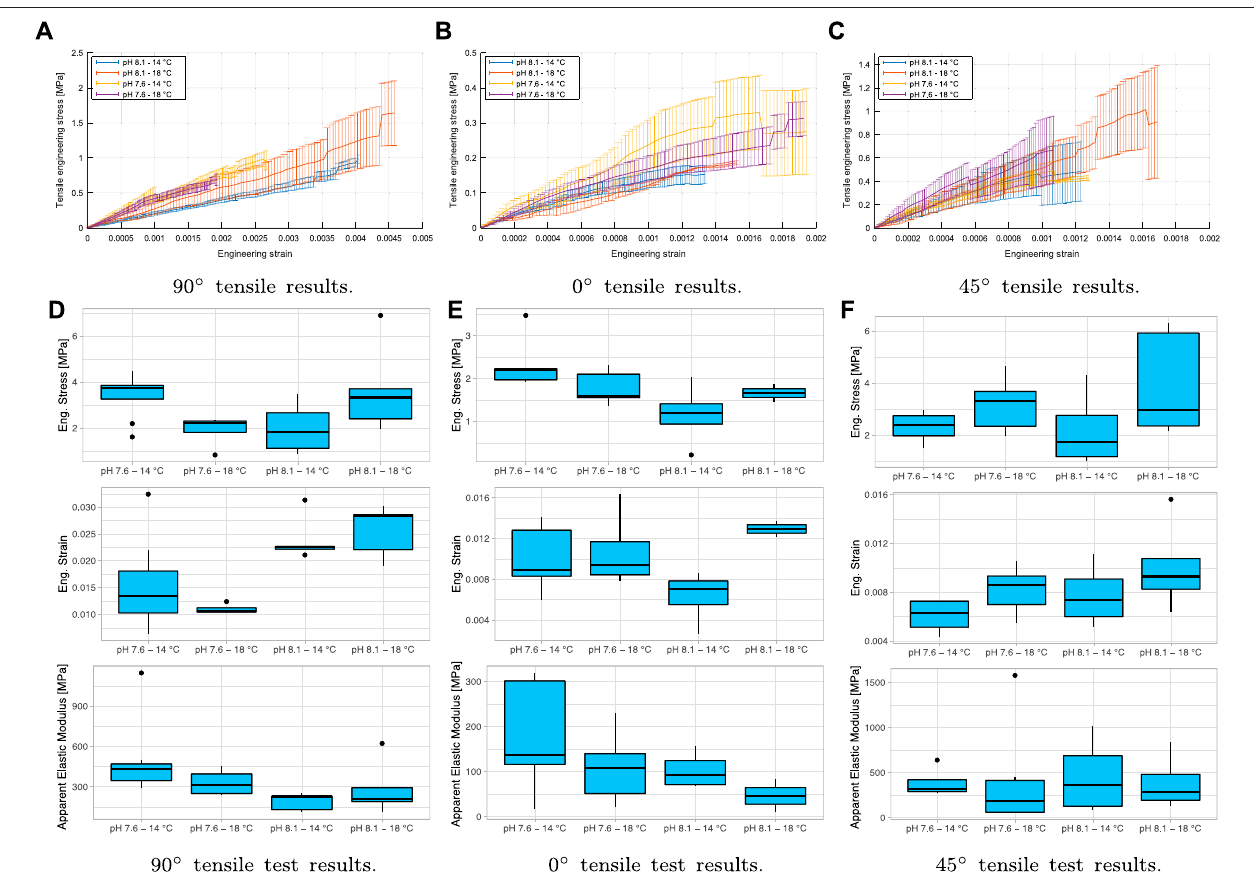
FIGURE 6 | Results of the tensile test apparent behavior in engineering stress against engineering strain: (A – C) shows the tensile results for 90 ° , 0 ° , and 45 ° orientations,respectively. (D – F) comparethemechanicalbehavioronthemaximumstrain,maximumengineeringstress,andtheelasticmodulus.( C ):extremevaluesof the